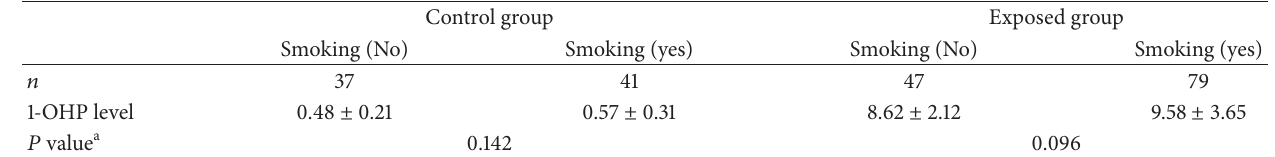
Table 2: 1-OHP levels by smoking use status in control and exposed